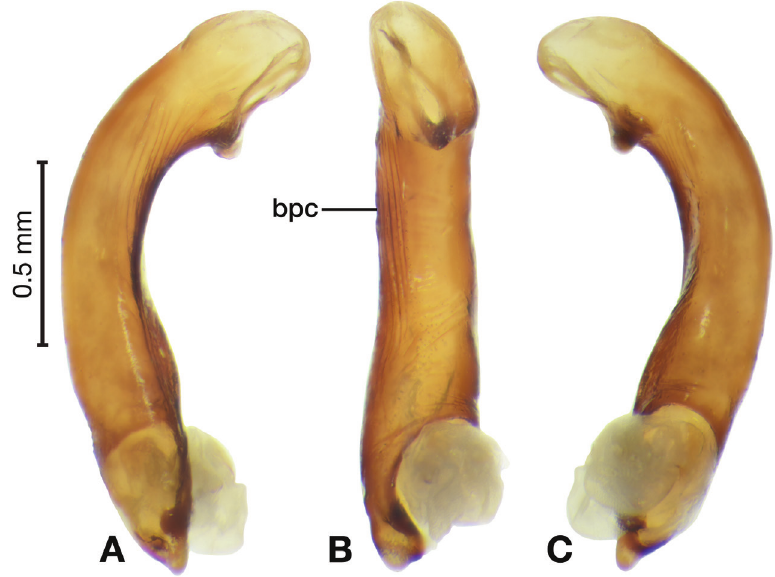
Figure 7. Digital images of male genitalia of Amphimenes beichatiensis sp. n.. A right lateral aspect B ven- tral aspect C left lateral aspect. Legend: bpc basal phallic carina.